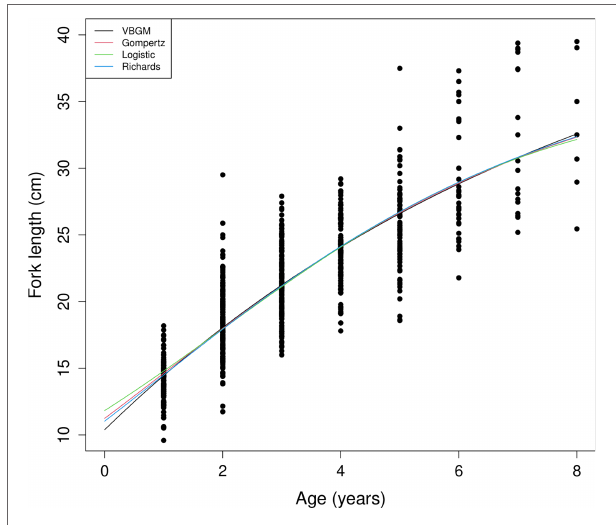
FIGURE 6 | Age and length of sex-combined data and fitted growth curves of the four growth models for brushtooth lizardfish off